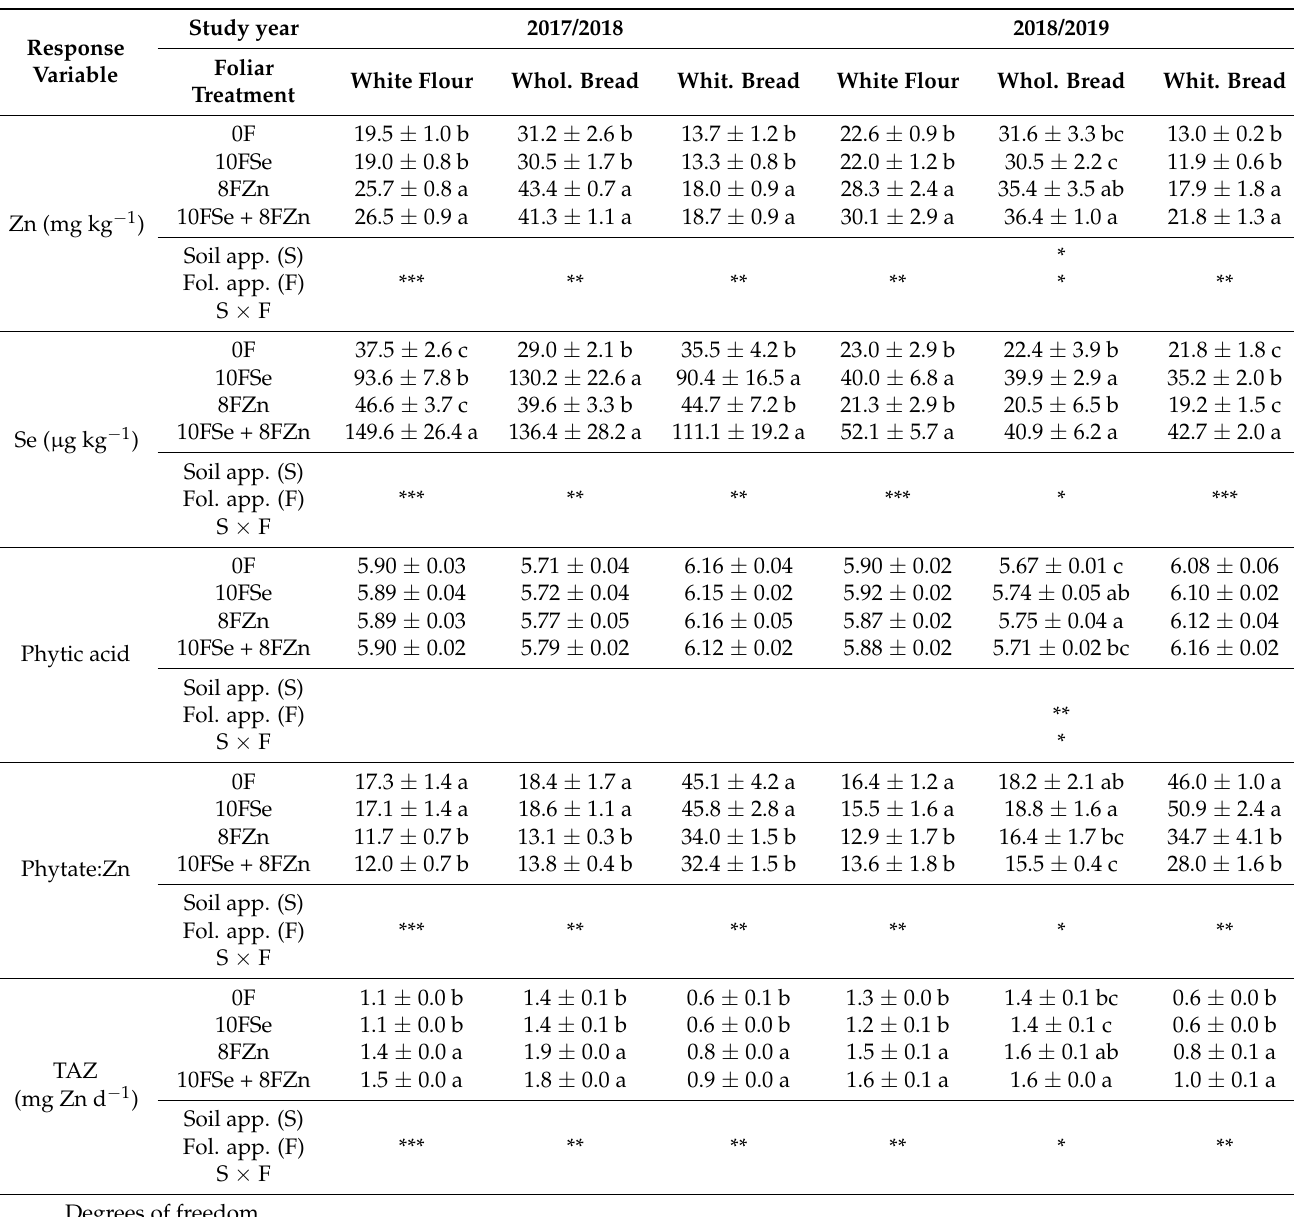
Table 2. Effect of the foliar treatment on the concentration of Zn and Se, phytic acid, molar phytate:Zn ratio and TAZ (daily absorbed zinc) in each fraction considered (white flour, wholemeal bread and white bread) in the two study years. Values are expressed as mean value ± standard error ( n = 4 for flour and n = 2 for bread). Levels of significance (* p ≤ 0.05, ** p ≤ 0.01, *** p ≤ 0.001) for main effects (Zn soil application and foliar application) and interactions according to ANOVAs are also shown.